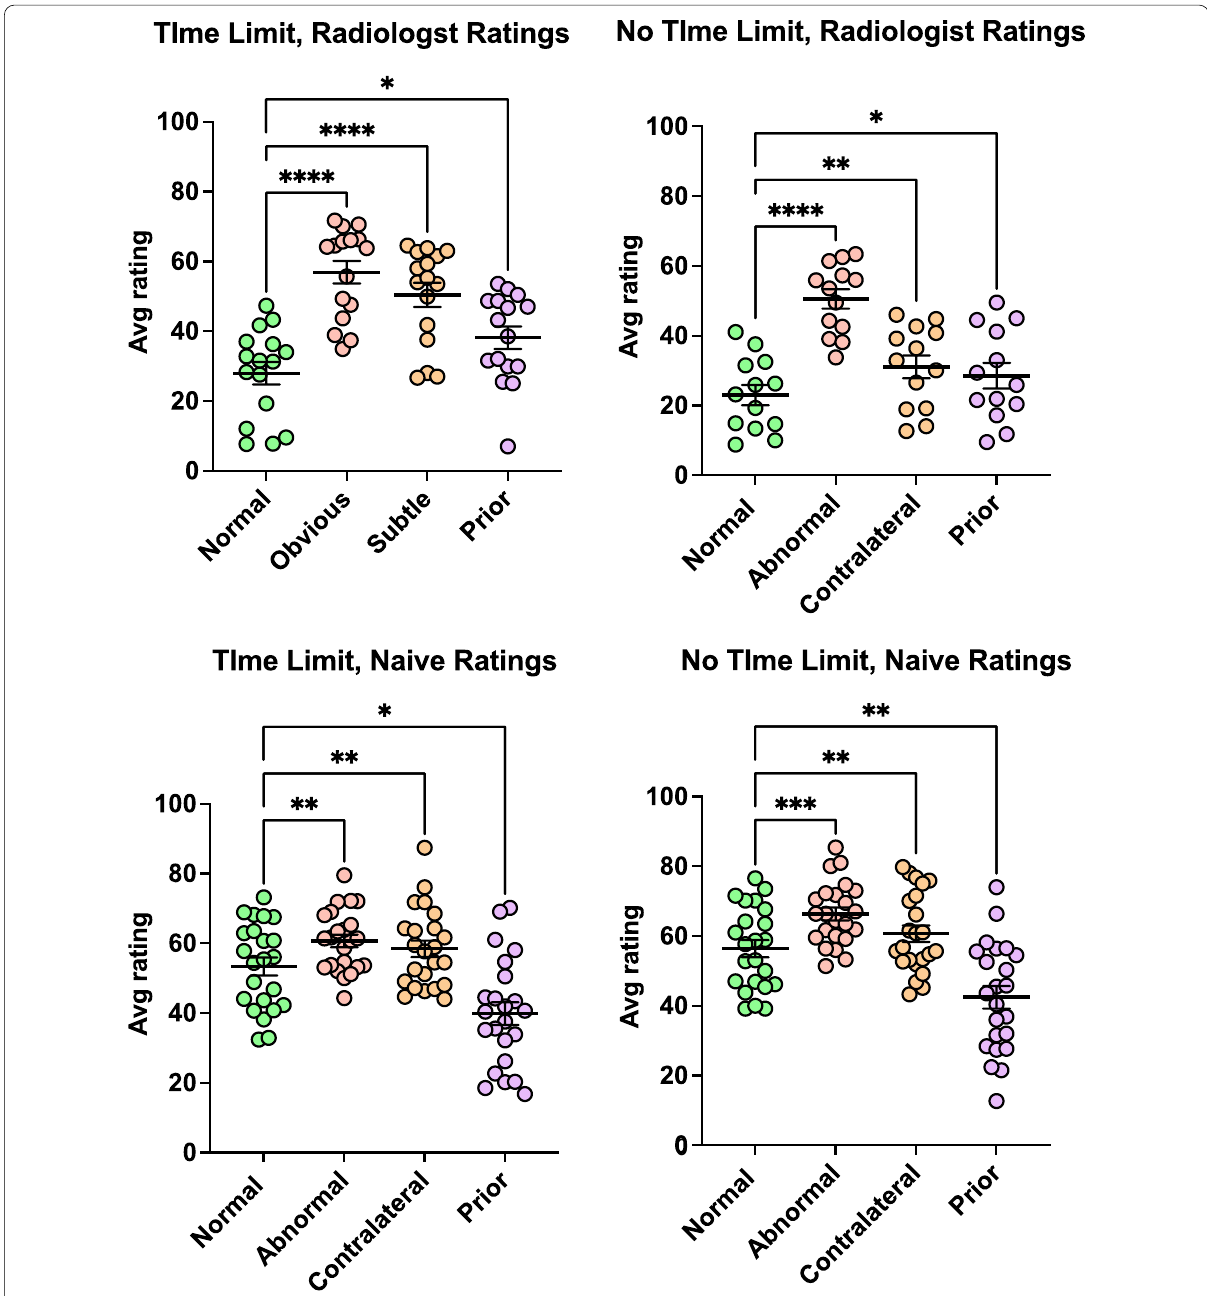
Fig. 2 Average ratings for each observer group for each type of image. Statistical results are Dunnett’s multiple comparisons tests, comparing each type of abnormal image to the normal